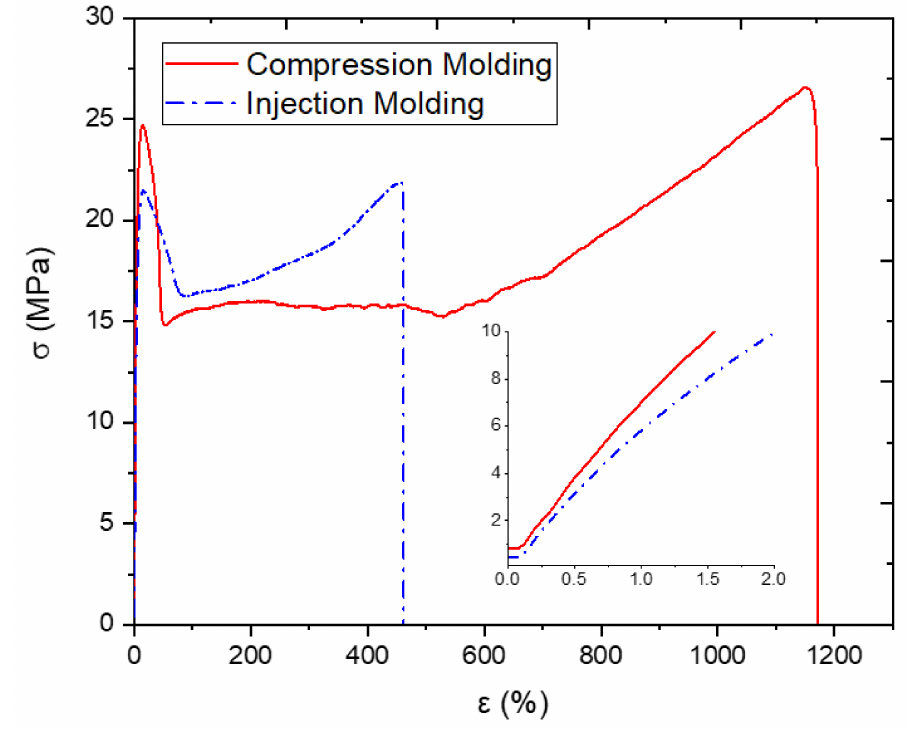
Figure 2. Compression and injection-molded samples’ stress–strain curves. The 1st phase, present in both samples, is a linear elastic response that can be observed in the insert of the graph. The initial increase reaches a maximum stress value, and then, the graph decreases. This first peak on the stress–strain curve will be taken as the yield strength of the material. The 2nd phase follows shows a steep drop in the stress–strain curve, which is attributed to a local reduction in the cross-sectional area of the gauge length—a phenomenon referred to as necking. The necking phenomenon is illustrated in Figure 3b. The 3rd distinct region is characterized by an increase in strain with a minimal fluctuation in stress, creating a plateau. During this stage, the necked region propagates along the gauge length of the sample due to the disentanglement and alignment of the polymer chains. Once the amorphous segments of the polymer are aligned, the crystalline segments will keep elongating and develop into micro-fibrils. This process is also known as plastic deformation, creating what could be considered a secondary specimen. The 4th stage shows a toughening in the response of the HDPE samples due to the effect of cold drawing. A rise in the stress–strain curve is seen until the sample